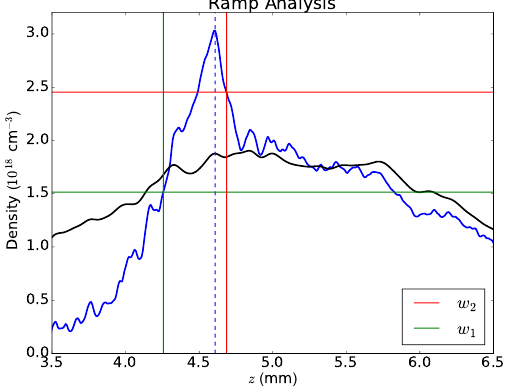
Figure 18. Example for ramp parameter analysis, undisturbed density in black.